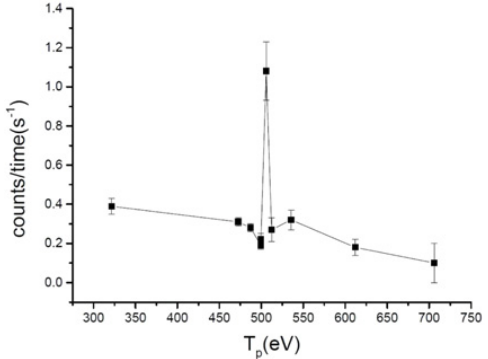
Figure 10. Plasma proton source line profile at 5 · 10 − 4 mbar source H 2 pressure, measured by varying the delay time between the gates and, thus, scanning the spike T p over the line width. The error bars denote the statistical error.